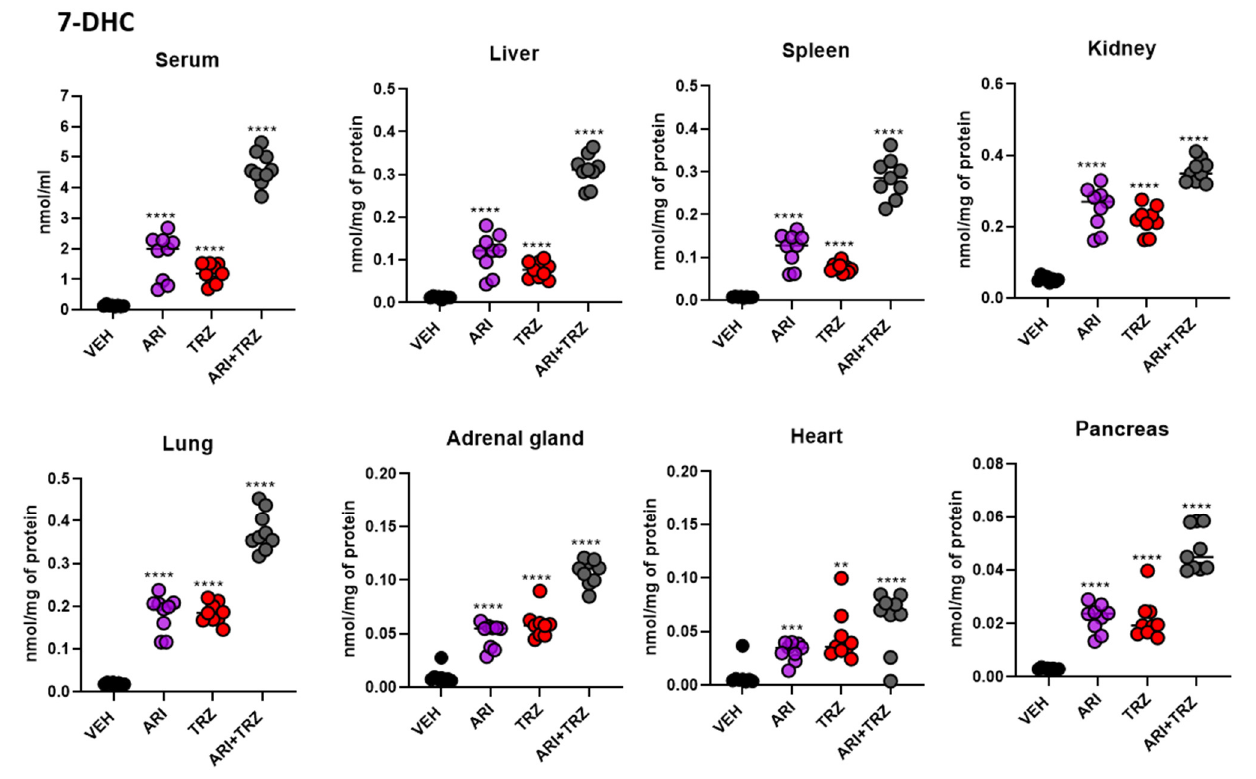
Figure 5. Combined ARI and TRZ treatment results in summative or synergistic increase in 7-DHC levels. X axis represents treated groups, Y axis denotes 7-DHC concentration normalized to nmol/mL (serum) or nmol/mg of protein (tissues). Black asterisk denotes significance compared to baseline levels. ** p < 0.01, *** p < 0.001, **** p < 0.0001. 7-DHC fold changes over vehicle treatment are presented in Figure S5, upper panel.